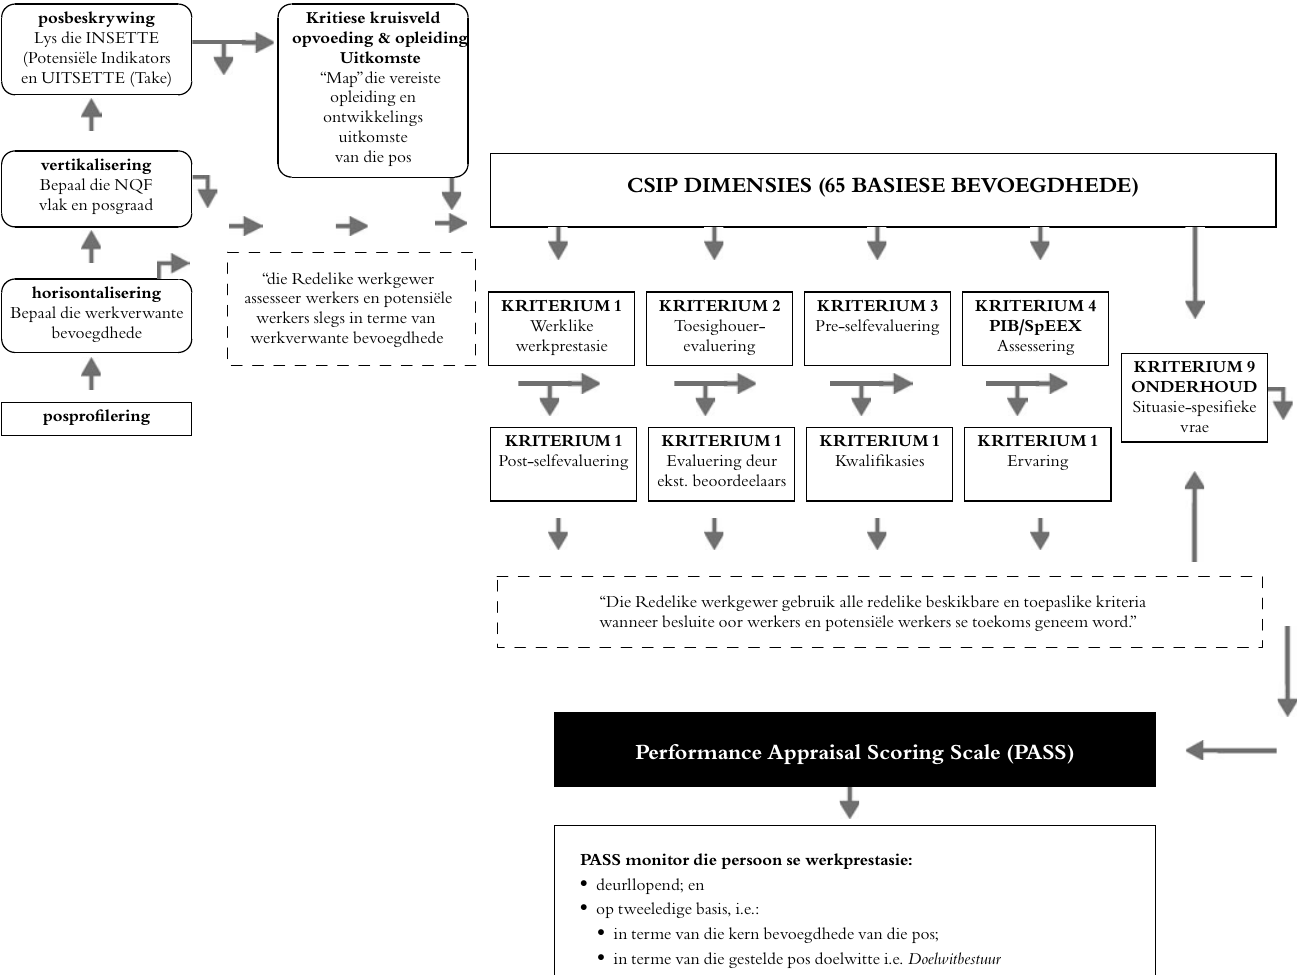
Figuur1:CSIPDiagram(PIBAssociates,